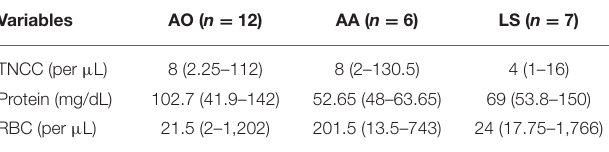
TABLE 3 | Comparison of fluid analysis parameters across samples with abnormal cytology.